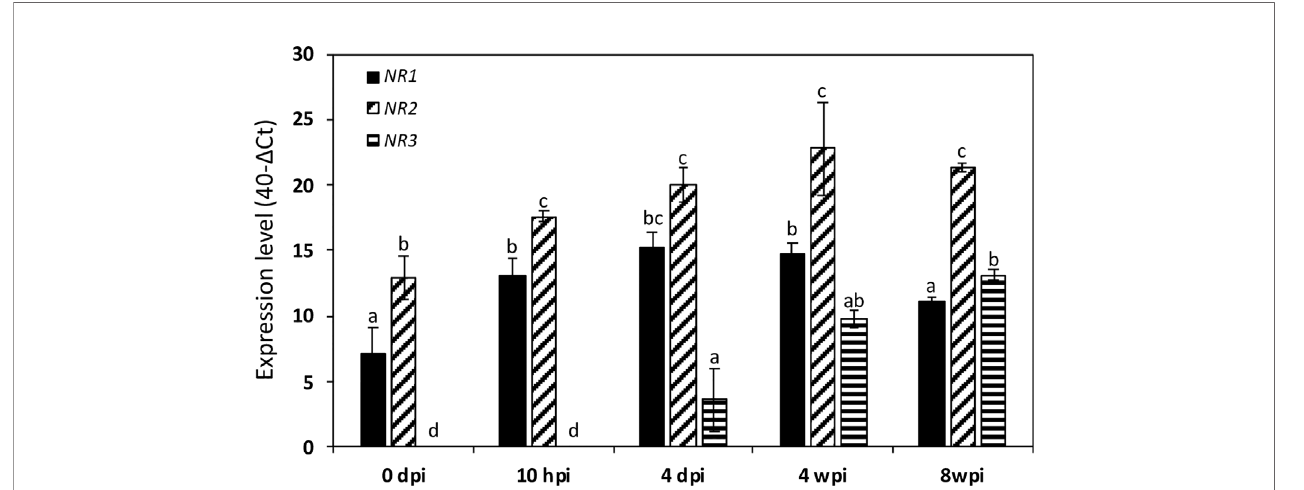
FIGURE 4 | Expression of Medicago truncatula NR genes at various times of the symbiotic process. The data are drawn from the same experiments as those presented in Figure 3 . Values followed by different letters are signi fi cantly different according to one-way ANOVA analysis followed by a Fisher test (P<0.05). dpi, day post inoculation; hpi, hour post inoculation; wpi, week post inoculation.